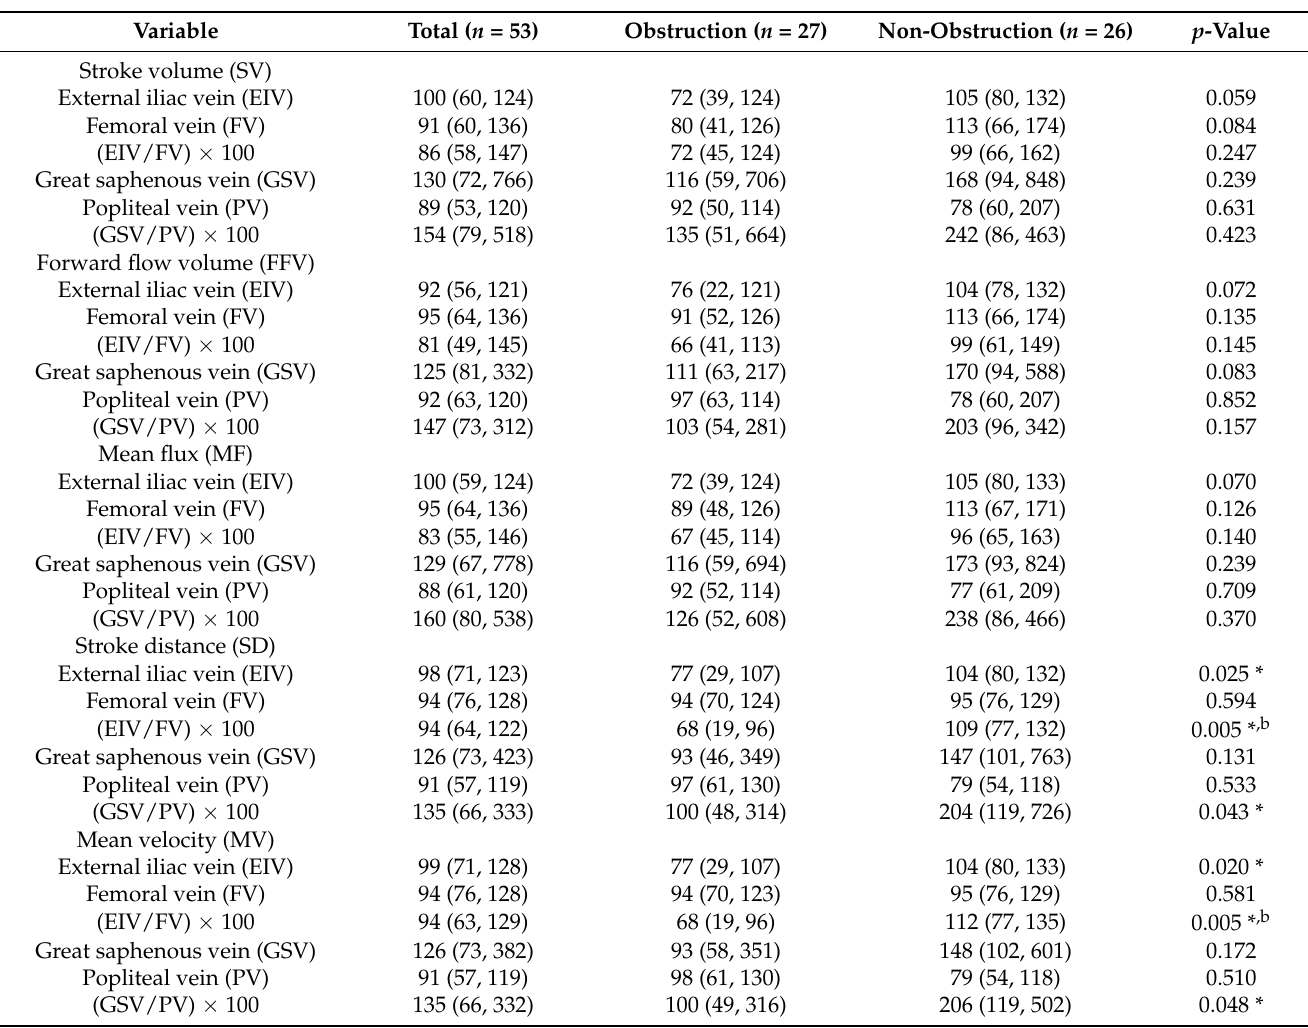
Table 2. The performance of the QFlow parameters (the ratio of morbid limb to normal limb) in discriminating obstructive venous disease.